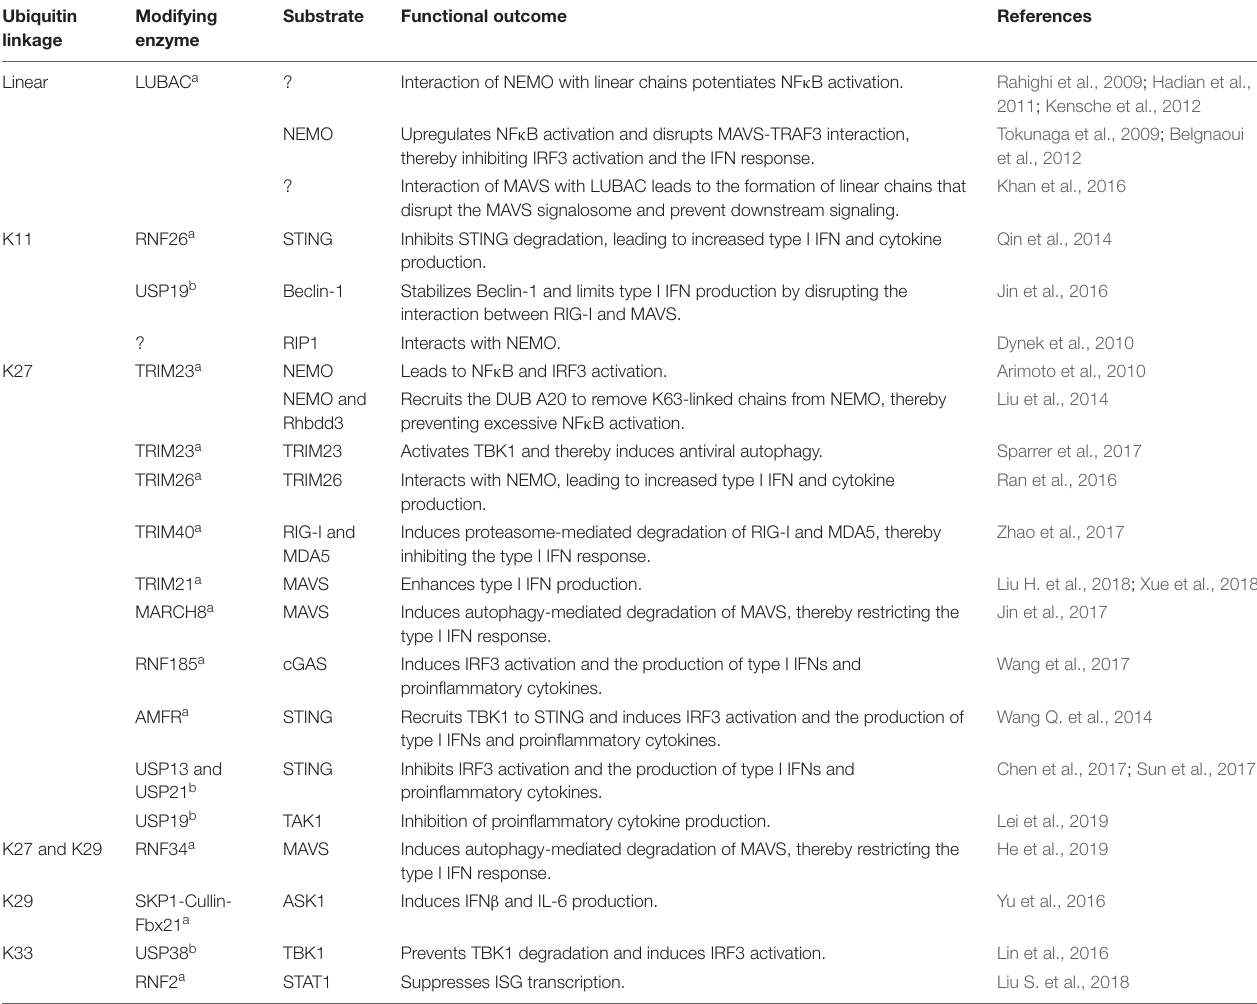
TABLE 1 | Overview of the functions of atypical ubiquitination and the associated E3 enzymes and DUBs. Ubiquitin